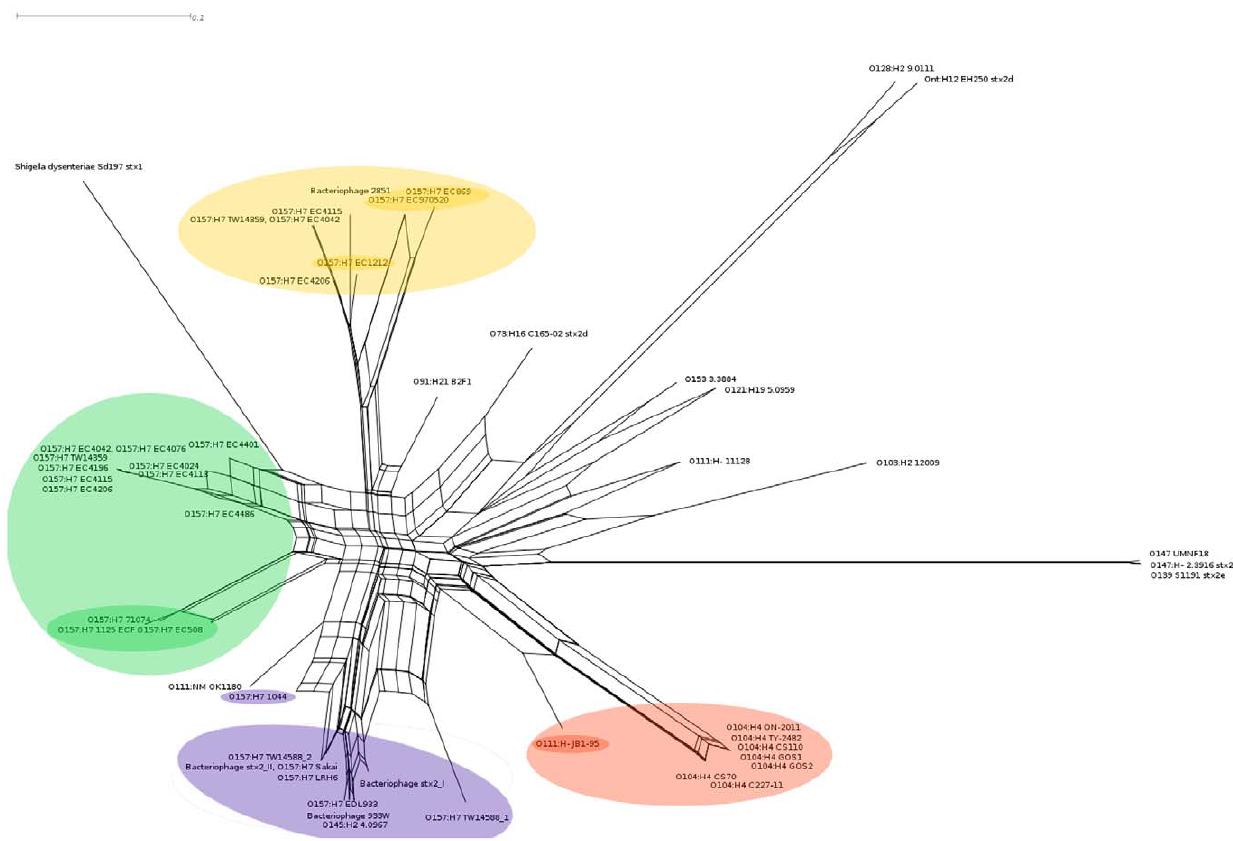
Figure 1. The neighbor-net visualization of the Stx2 ‘‘pan-genome’’ among E.coli Stx2-bacteriophage and a bacteriophage from Shigelladysenteriae (Table 1). The ‘‘pan-genome’’ consists of 500 bp sequence fragments present in at least 3 bacteriophage sequences at an 85% sequence identity threshold. Labels represent the host-source of the bacteriophage as serotype followed by strain name. Red shading: Stx2-phage from O104:H4 outbreak isolates (light); O111:H- strain JB1-95 (dark). Purple shading: Stx2-phage from O157:H7 lineage I strains; related Stx2- bacteriophge; O145:H2 strain 4.0967. Green shading: Stx2-phage from O157:H7 lineage I/II strains; the sub-group of lineage I/II Stx2-phage most closely related to the O104:H4 isolate phage. Yellow shading: Stx2c-phage from O157:H7 lineage I/II strains and bacteriophage 2851 (light); O157:H7 lineage II strains (dark).